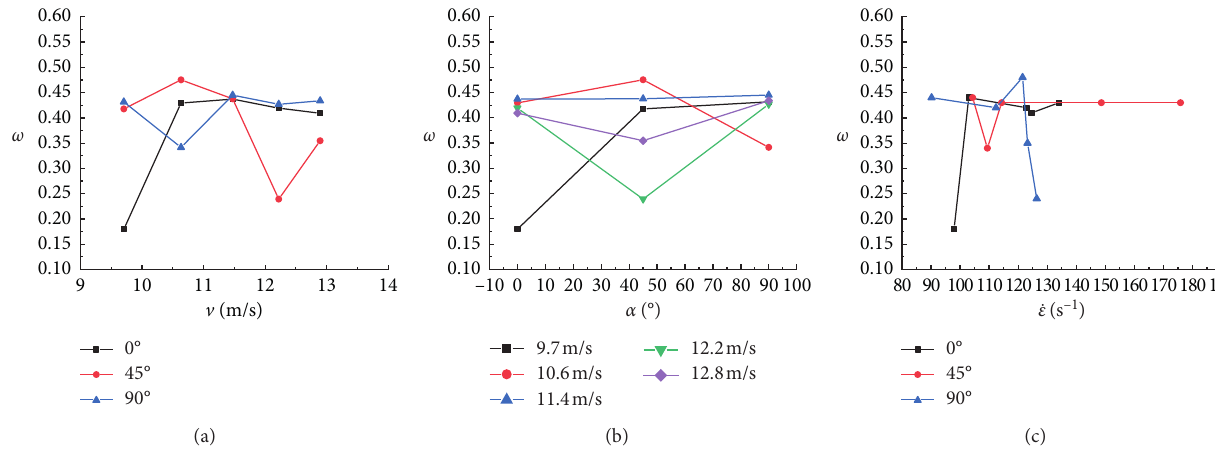
Figure 16: Relationship between energy absorption rate and loading rate, prefabricated fracture angle, and strain